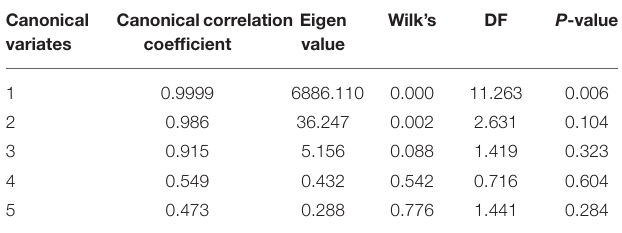
TABLE 9 | Typical correlation between heavy metal elements in the egg white and heavy metal concentration in the oviduct. Canonical variates